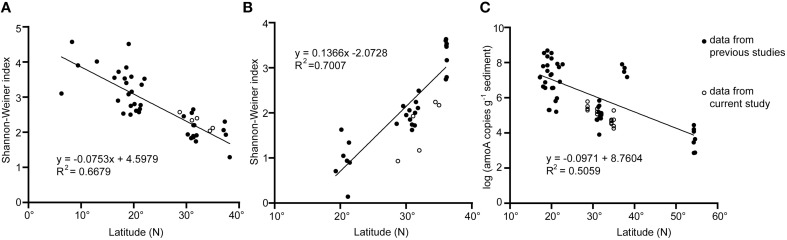
Diversity of archaeal and bacterial amoA and abundance of archaeal amoA changed along latitude in sediments of the western Pacific marginal seas. (A) diversity of AOA amoA gene; (B) diversity of AOB amoA gene; (C) abundance of AOA amoA gene. Data were obtained from the present study and Dang et al. (2008, 2009, 2010a,b, 2013), Park et al. (2008); Cao et al. (2011, 2012); Zheng et al. (2013, 2014), and Chen et al. (2014b).